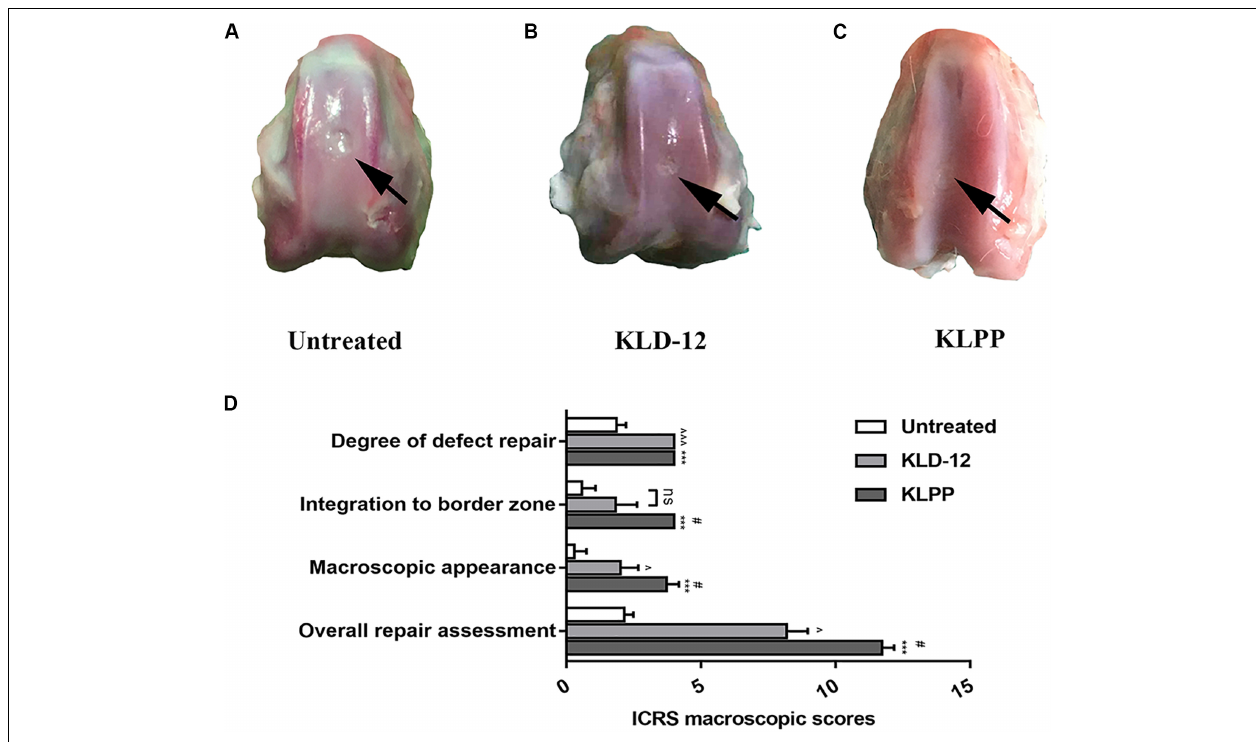
FIGURE 6 | Gross necropsy photographs of untreated defects (A) and defects treated with KLD-12 hydrogel (B) and KLPP hydrogel (C) . (D) ICRS macroscopic scores at 12 weeks. ( n = 3, mean ± SD.*, KLPP vs. Untreated, *** p < 0.001; #, KLPP vs. KLD-12, # p < 0.05; ∧ , KLD-12 vs. Untreated, ∧ p < 0.05, ∧∧∧ p < 0.001. ns: no